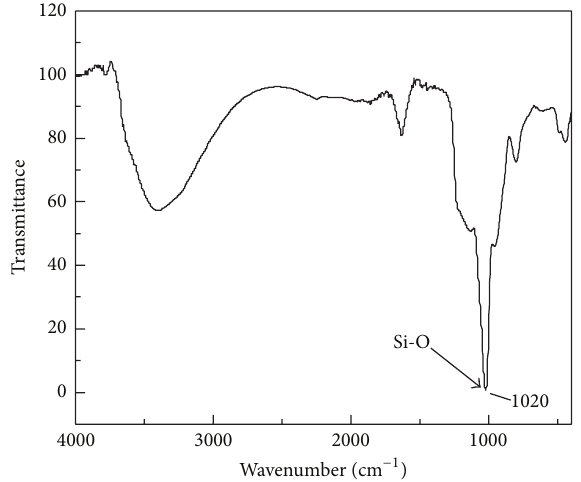
Figure 2: FTIR transmission spectra of SiO 2 thin film.